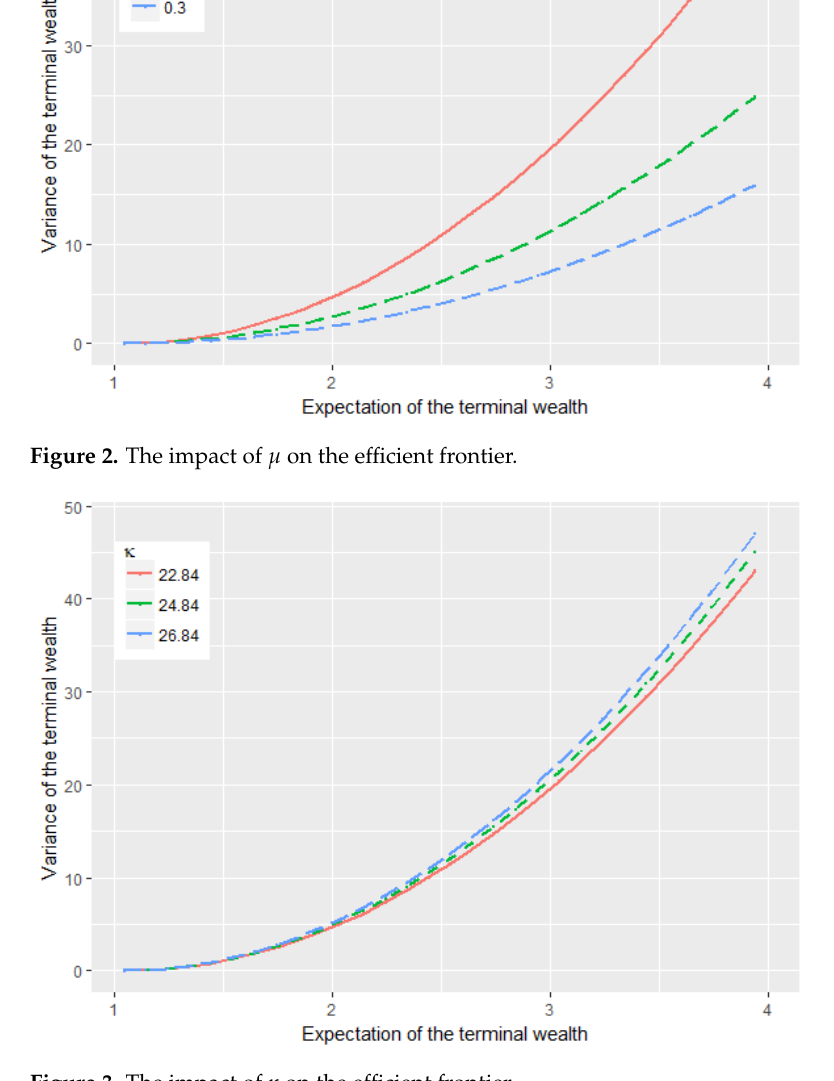
Figure 3. The impact of κ on the efficient